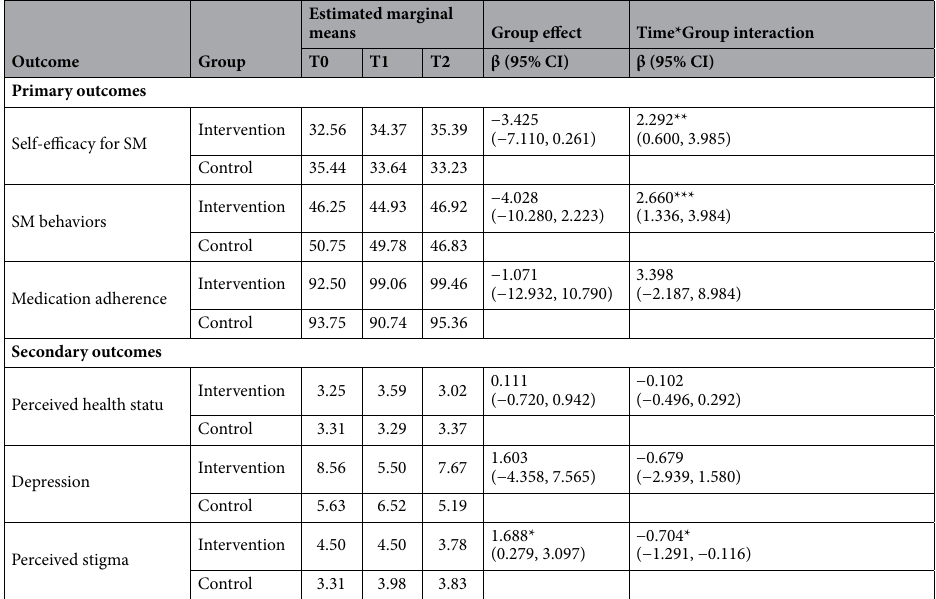
Table 1. Comparison of the changes in the scores of the self-management outcomes between the intervention and control groups (N = 33). a SM = Self-management. b CI = Confidence Interval. c T0 = baseline, T1 = second test (4 weeks), T2 = posttest (8 weeks). d Sexual identity, daily sleep hours, viral load, and self-efficacy for self- management were included as covariates. * p < .05, ** p < .01, *** p <